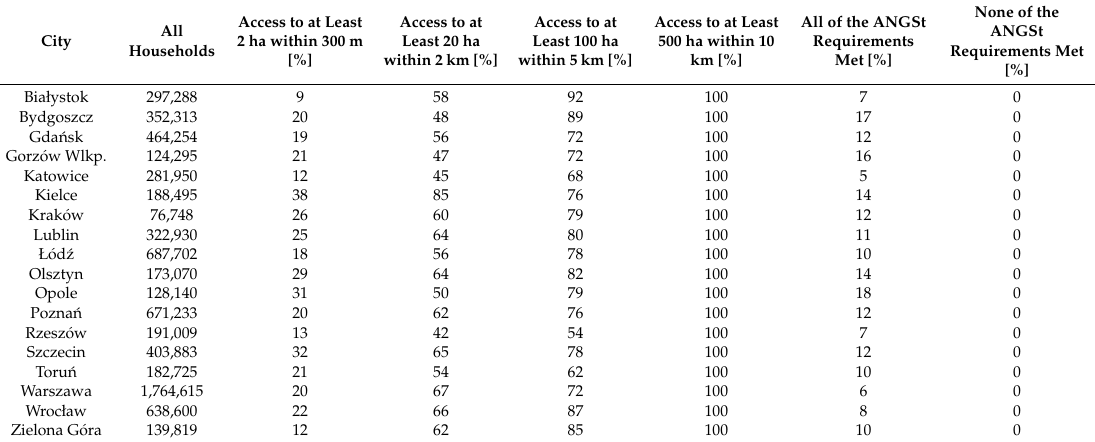
Table 3. The accessibility of green areas according to ANGSt standards in voivodeship cities in